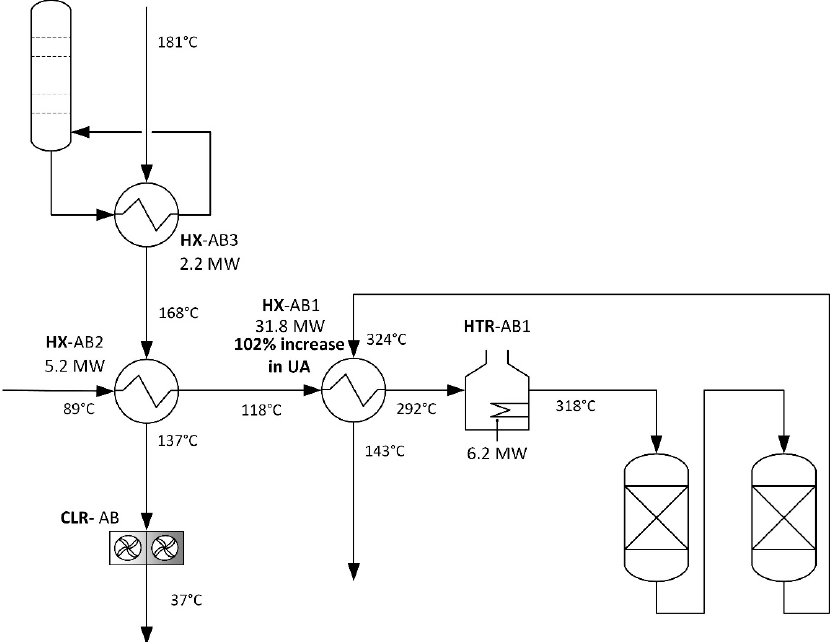
Figure A3. Retrofit proposal 1B.